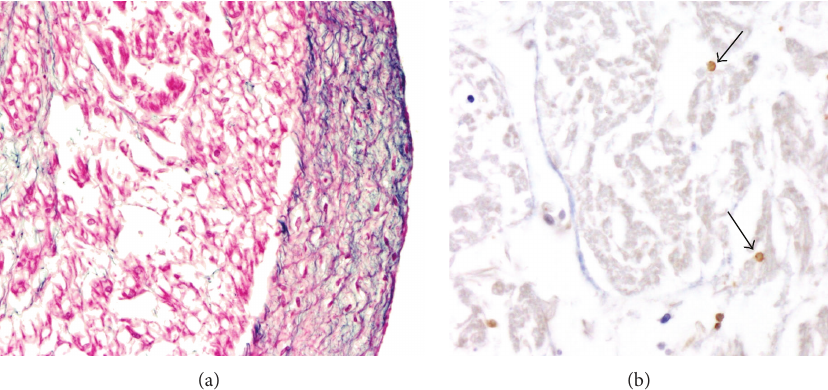
Figure 2: Histopathology obtained during the infant autopsy. (a) Cardiac hematoxylin and eosin staining showed dilatation and massive endocardial fibroelastosis appearing as a thick white scale covering the inner surface of the left ventricle cavity. (b) The immunohistochemical analysis showed extensive inflammatory cell (arrow) infiltrates in the